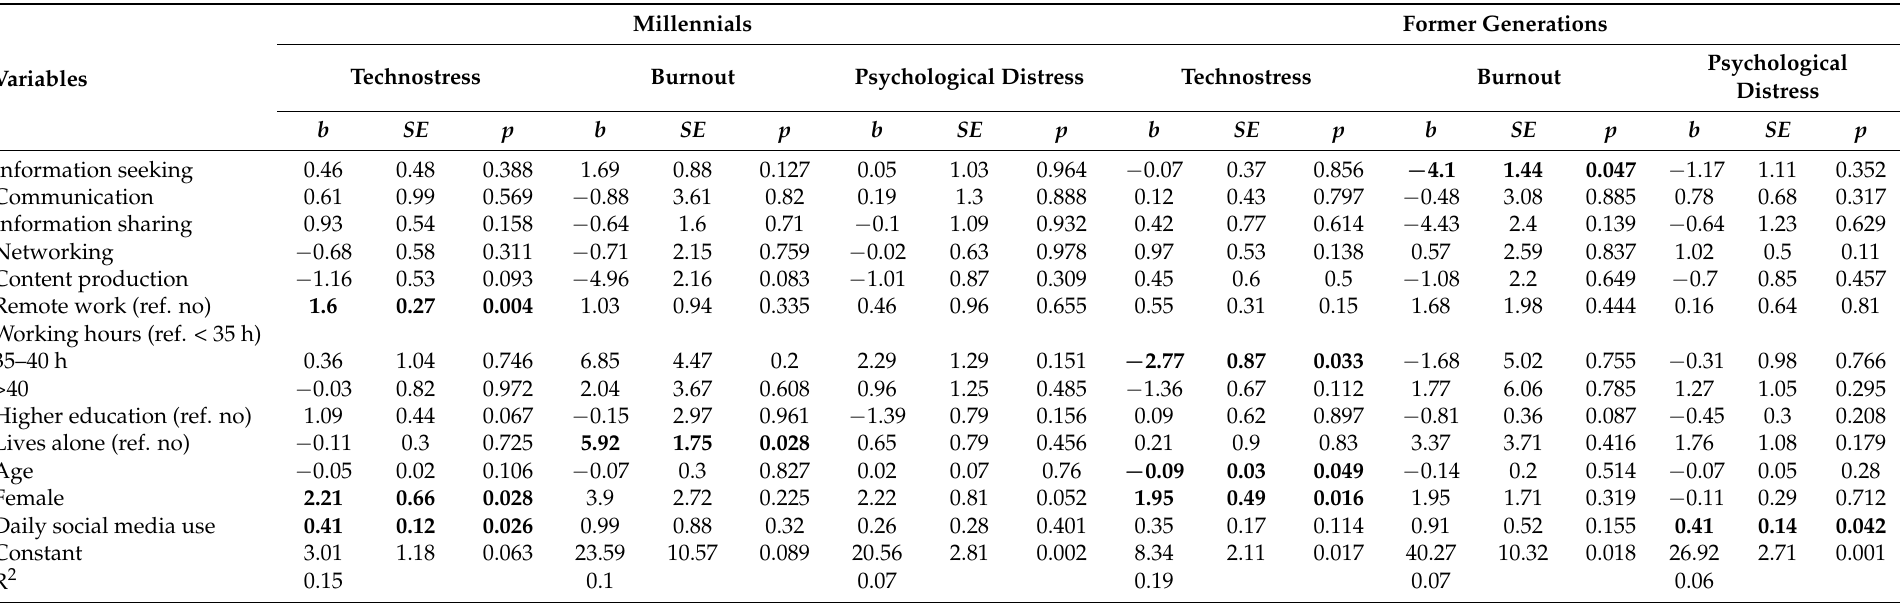
Table 4. Linear regressions on associations of social media use motivations on psychological well-being among expert organization workers ( N =